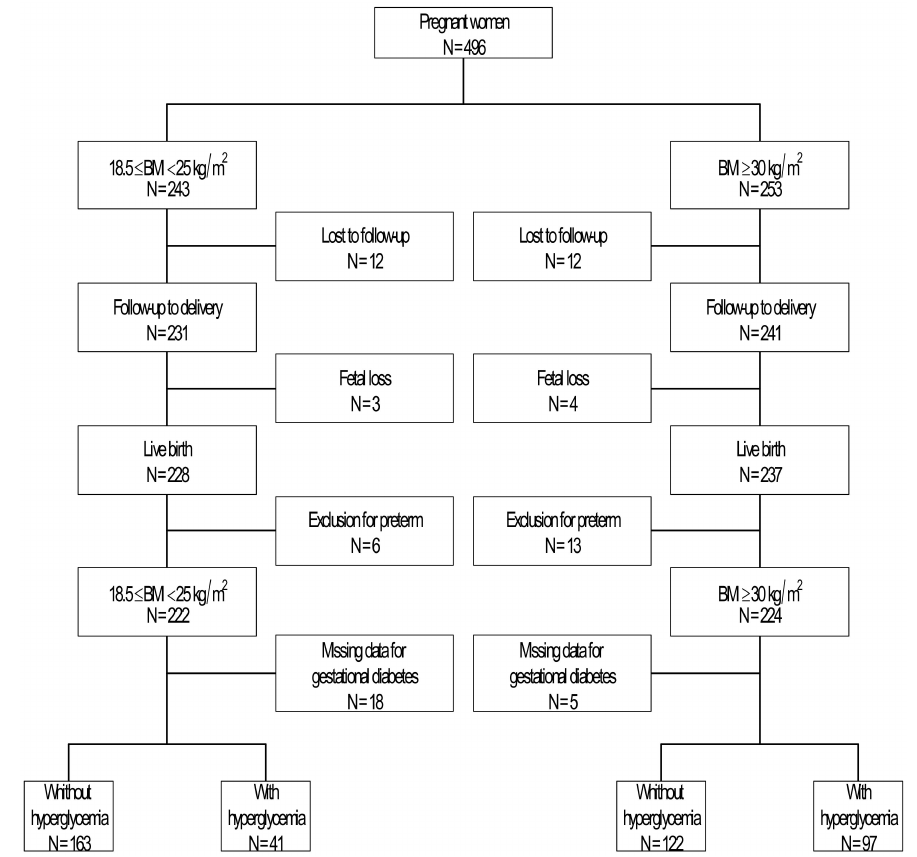
Figure 1. Flowchart of the study. BMI: Body mass